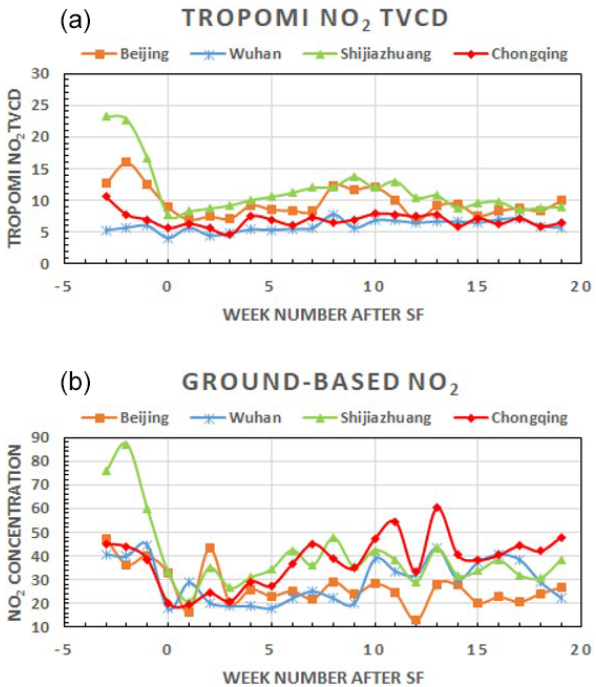
Figure 9. Time series of weekly averages of (a) TROPOMI-derived NO 2 TVCDs (10 13 molec.cm − 3 ) over Shijiazhuang, Wuhan, Chongqing and Beijing for weeks − 3 to 19 and (b) surface con- centrations of NO 2 (µgm − 3 ) over these cities, plotted together in one plot from Figs. 6–8 and